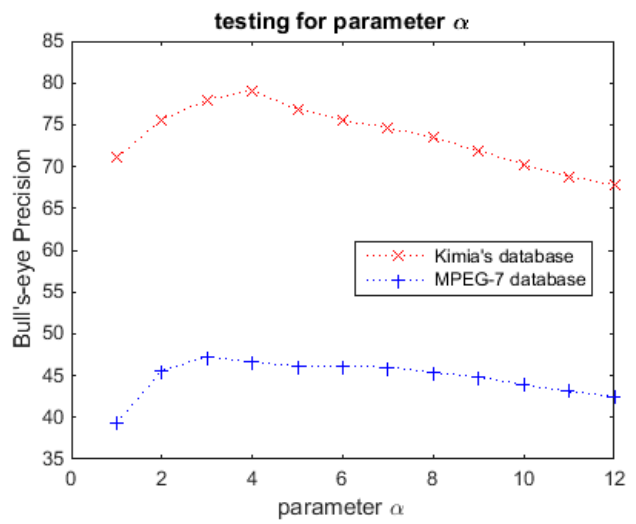
Figure 8. Bull’s-eye test with different values for parameter α in Equation (18).